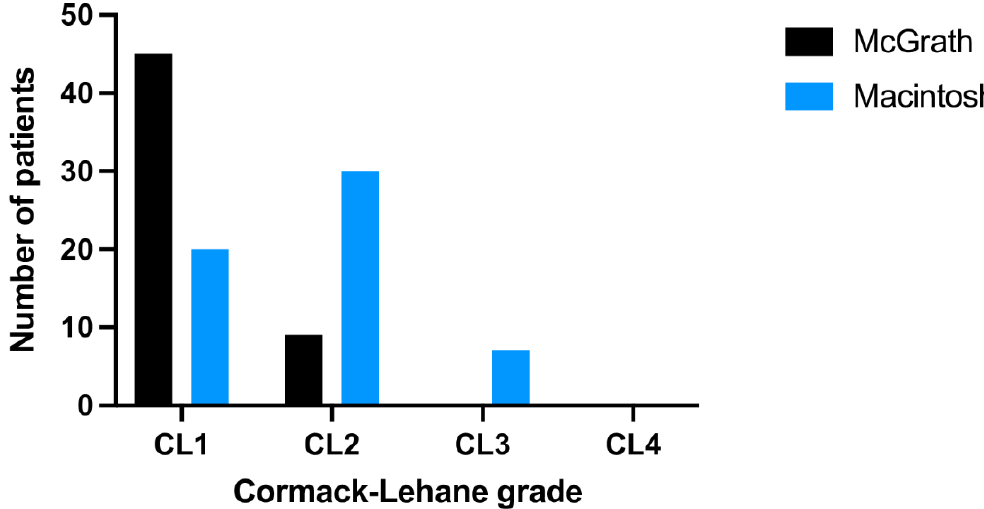
Figure 3. Cormack-Lehane grades in a scenario with either the McGrath or the Macintosh laryngoscope in a scenario without PPE-AGP.